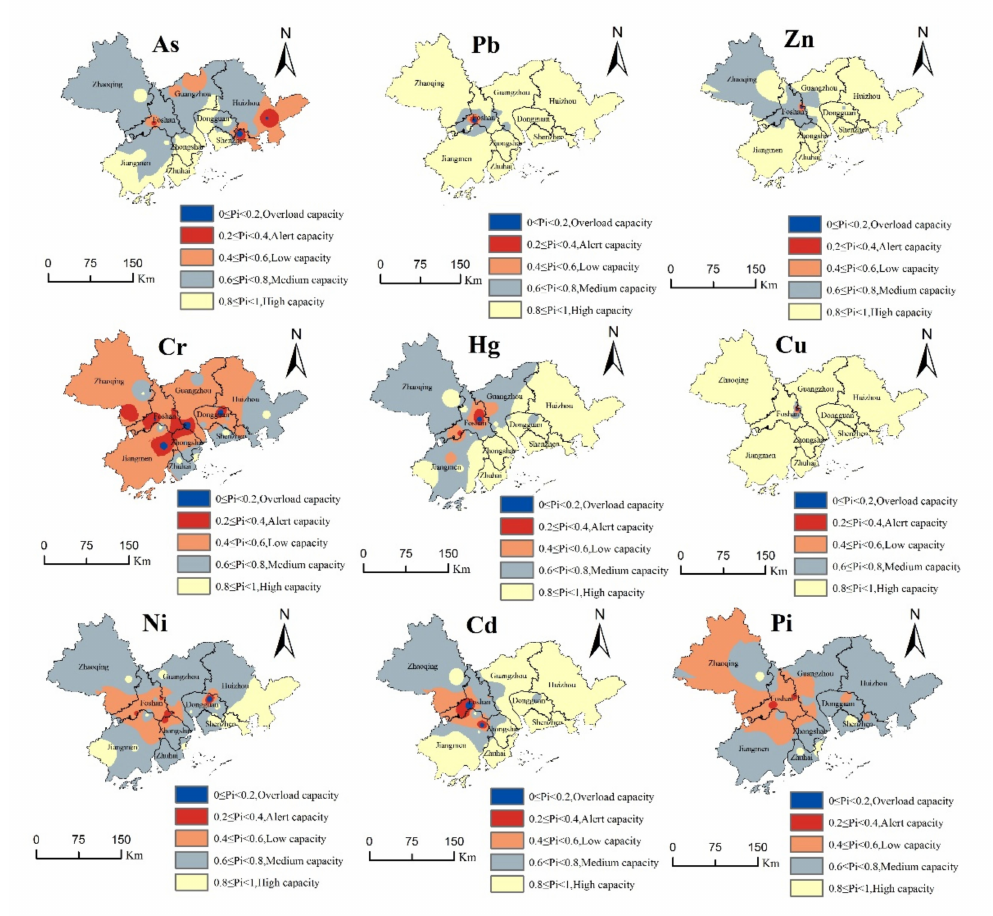
Figure 4. Evaluation map of the soil heavy metal environmental